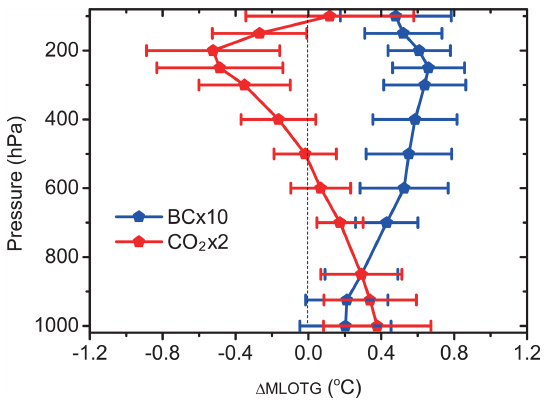
Figure 11. Changes in multimodel mean (MMM) of the MJJAS meridional land–ocean thermal gradient ( (cid:49) MLOTG; unit: ◦ C) un- der increasing BC and GHGs. The MLOTG is defined as the differ- ence between the Asian region (10–42.5 ◦ N, 60–125 ◦ E) and ocean ( − 10–10 ◦ N, 60–125 ◦ E). Error bars of the MMM indicate the stan- dard